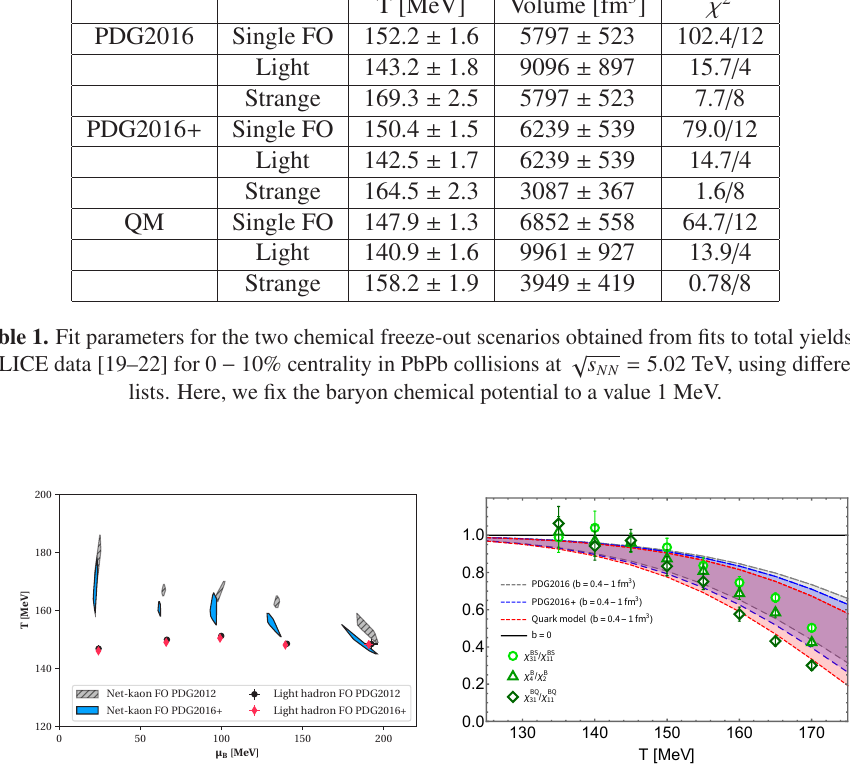
Figure 2. Left: Freeze-out parameters from light hadron and net-kaon fluctuations following the anal- ysis from Ref. [2] with di ff erent particle lists. Right: Fourth-to-second order susceptibilities predicted to be equal in the EV-HRG model. Lattice data from Ref. [25] are shown in green with error bars, while the calculations within the EV-HRG model are shown as bands for a range of excluded volume parameter, b , and for di ff erent hadronic lists. The ideal HRG result corresponds to the line at